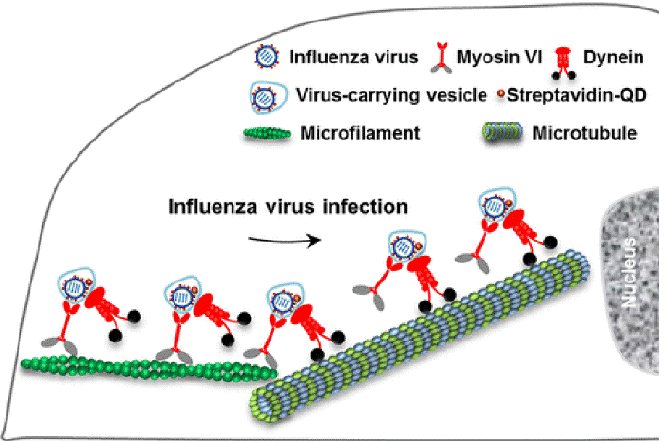
Figure 3. Transport model of influenza virus from AFs to MTs; the illustration is reprinted (adapted) with permission from [9]. Copyright {2017} American Chemical Society.